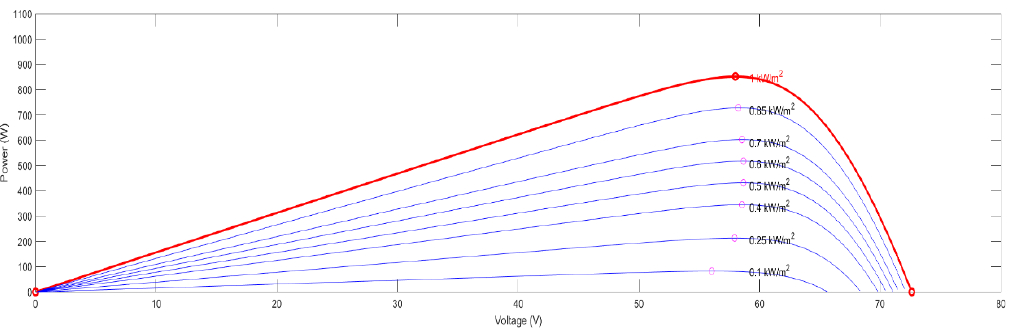
Figure 12. I-V curve simulation of the selected panel in different irradiances.